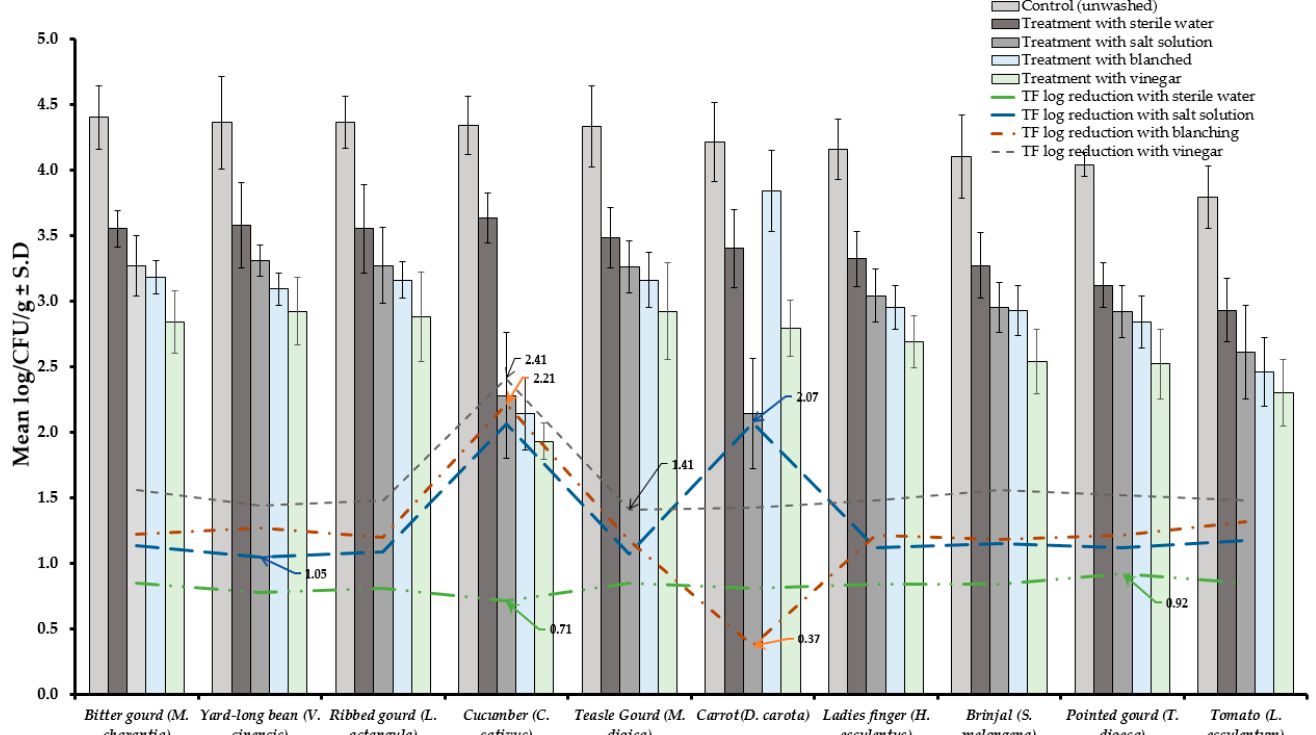
Figure 4. Four different treatments (sterile water, salt solution, blanched, and vinegar) were observed on total viable bac- terial load (TVBC) decontamination from the surface of 10 different types of vegetables. Data are mean ( n = 4) ± standard deviation.